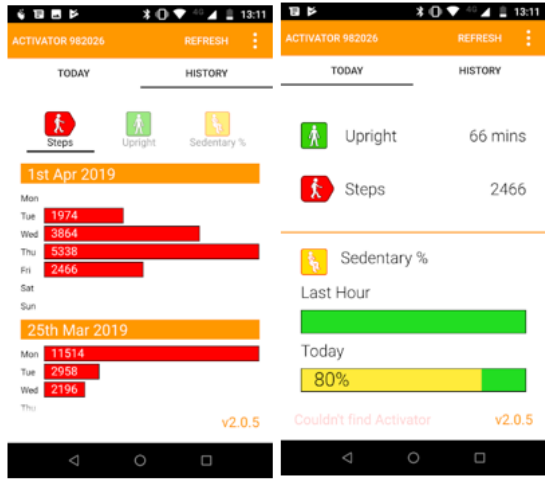
Figure 2. Screenshots of visual feedback provided by the